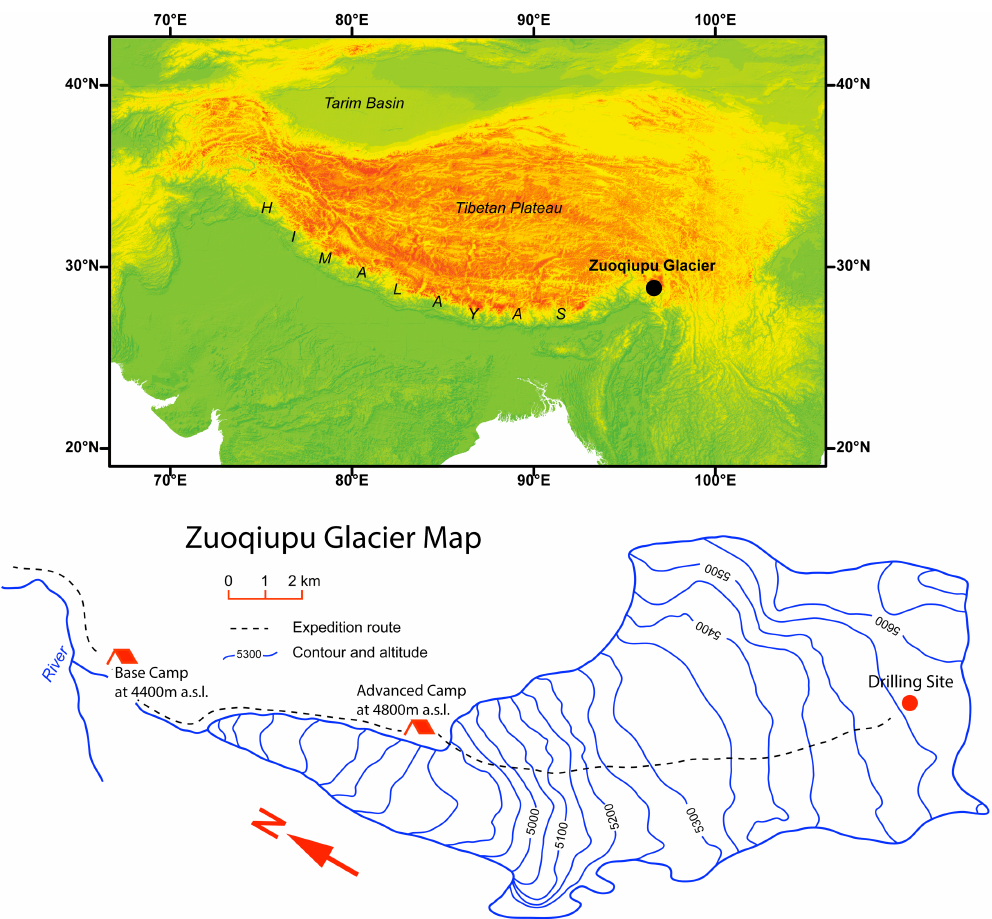
Figure 1. Site location of Zuoqiupu glacier (top): black circle represents the location of Zuoqiupu glacier, and warm colors indicate high elevations over the Tibetan Plateau. Detailed elevation contours of the Zuoqiupu glacier are shown in the bottom panel. Red circle marks the ice-core drilling